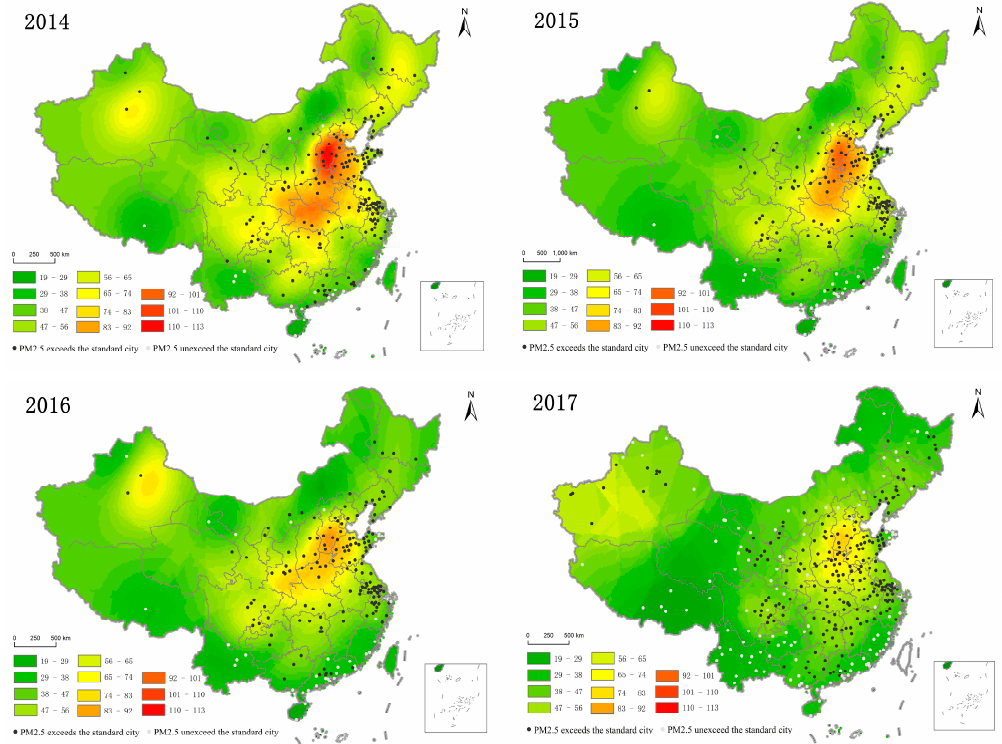
Figure 4. Spatial distribution of annual average PM 2.5 concentration in Chinese cities